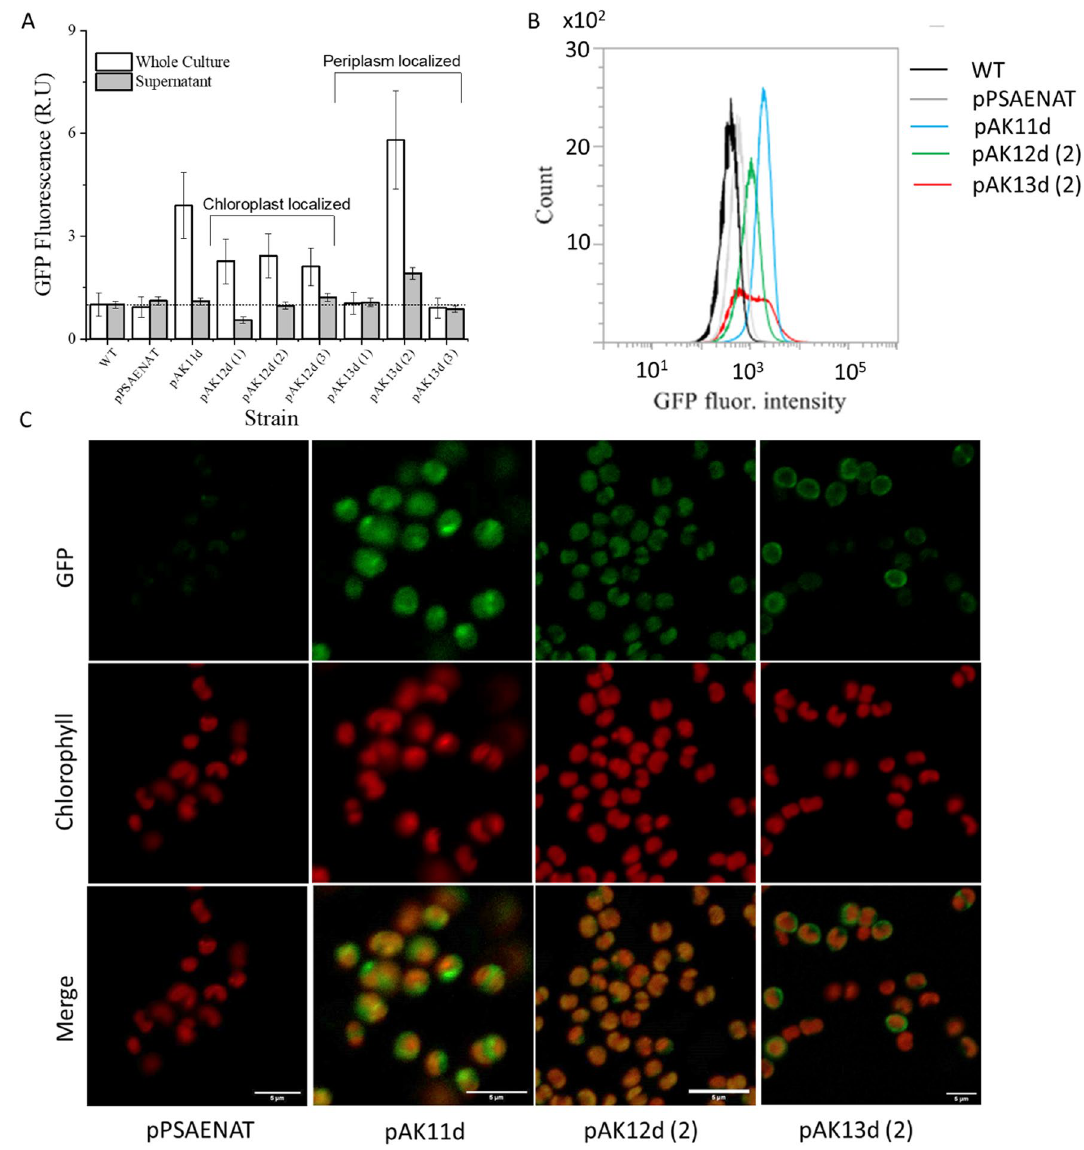
Figure 4. Phenotypic analysis of GFP expressing strains: ( A ) GFP fluorescence of whole culture and cell-free supernatant using a plate reader (excitation (485/20), emission (520/20)). Raw data was first normalized to OD 600 for each culture as measured by the plate reader followed by a second normalization to the WT GFP signal. Data represent averages and standard deviations of three technical replicates. ( B ) Flow cytometry histograms for cell counts vs. GFP fluorescence intensity (BL1 channel, 530/30 nm) for the control strains (WT, pSAENAT) and the maximum GFP expressing transformant clones i.e. pAK11d, pAK12d (#2), pAK13d (#2) for the cultures used in ( A ). ( C ) Confocal microscopy images. 5 µm scale bar shown in the bottom